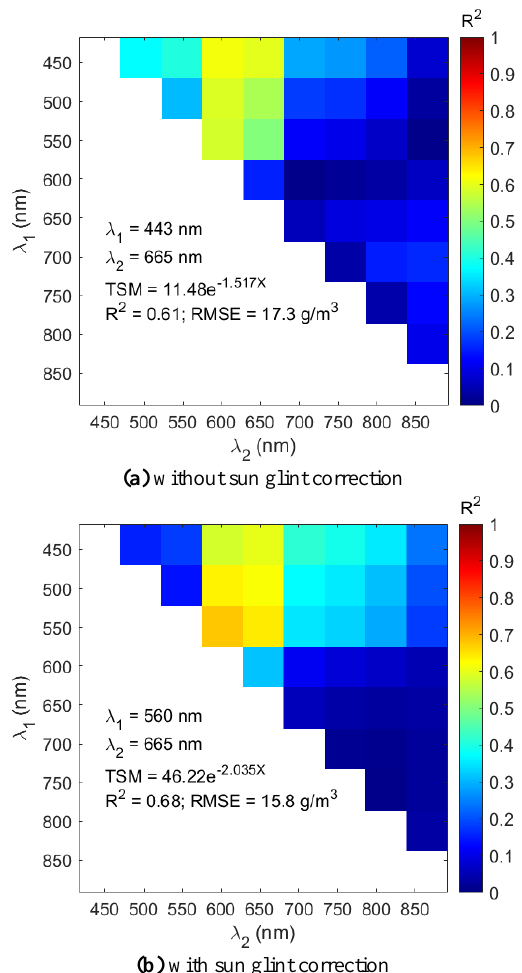
Figure 3 . Optimal band ratio analysis (OBRA) of training data (a) without and (b) with sun glint